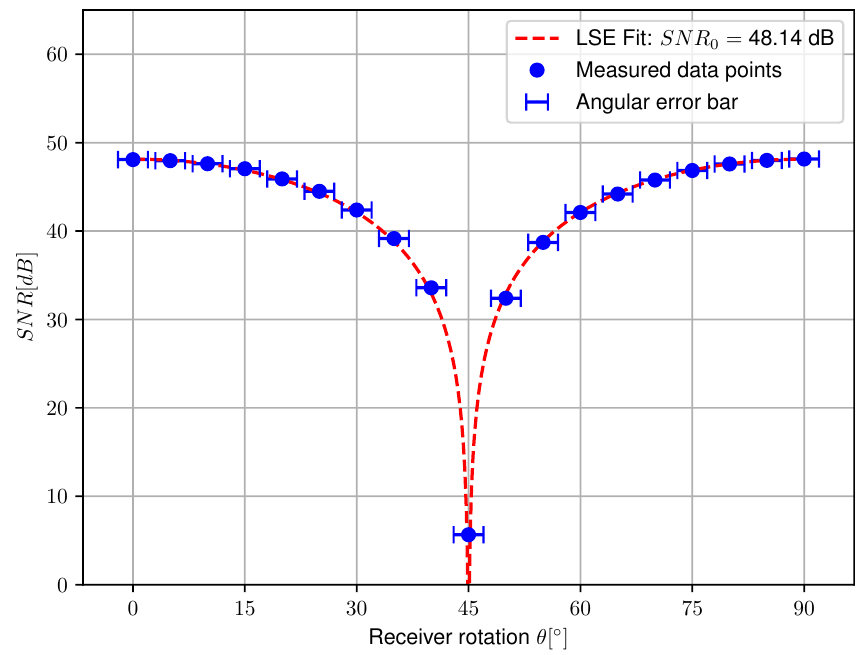
( a ) Measured SNR and theoretical fit as a function of receiver rotation θ at h = 1.35m for transmitted ‘1’-bits, for setup A [17]. Figure 11.